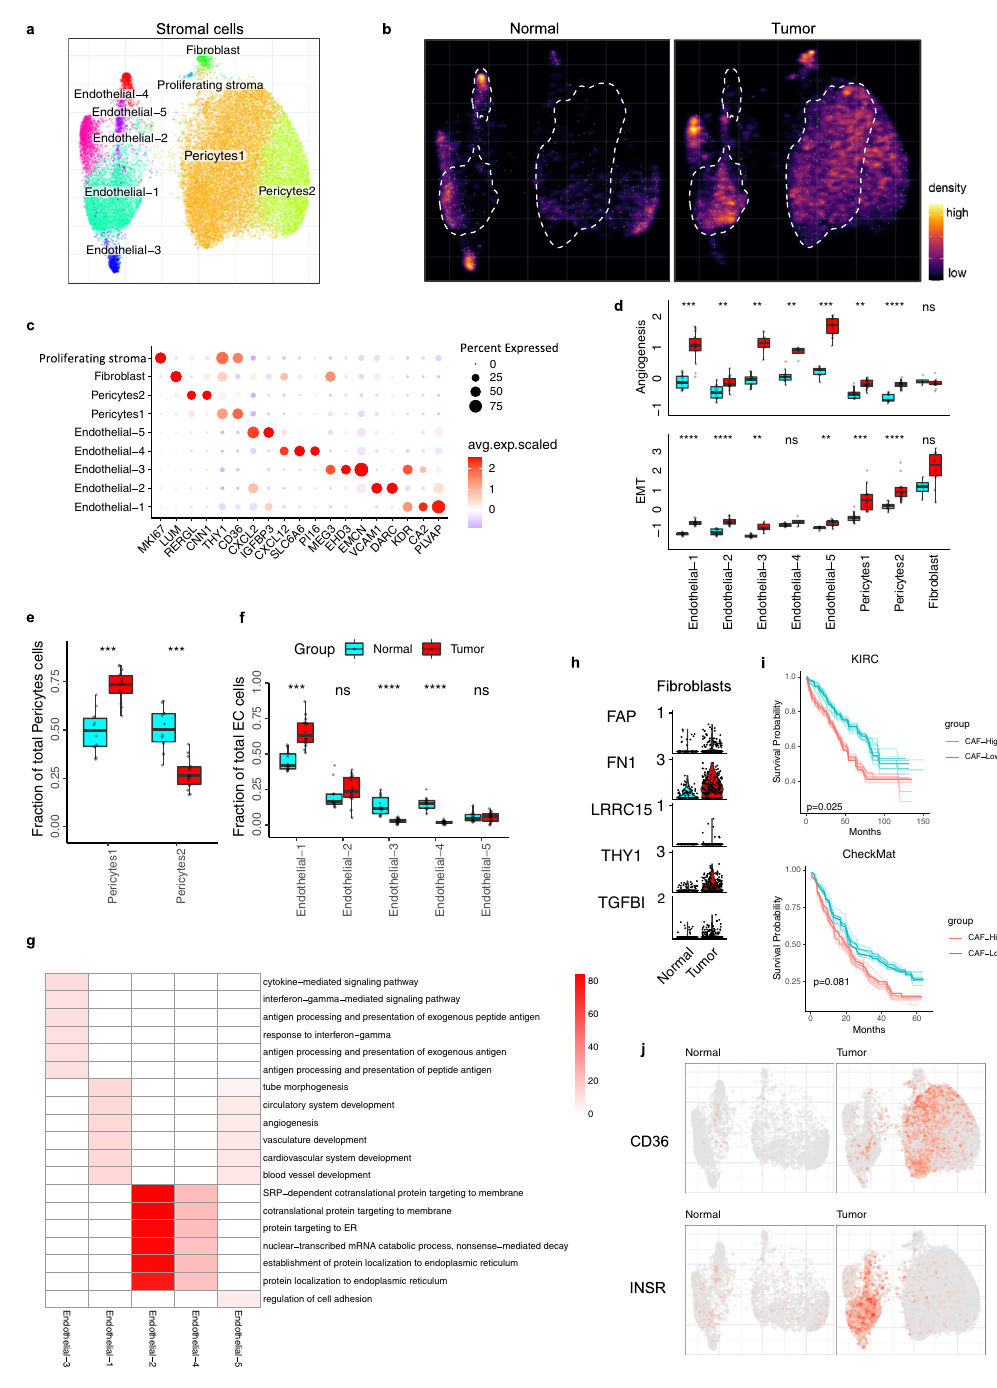
cell carcinoma (RCC) metastasis (GSE202813). Our analysis of 7 RCC metastasis cases shows the upregulation of metastatic signature compared to primarytumor cells,further demonstrating the reliability of tumor metastatic signature. Taken together, we identi fi ed a distinct tumor cell cluster with a transcriptomic program associated with metastatic potential and poor survival 43